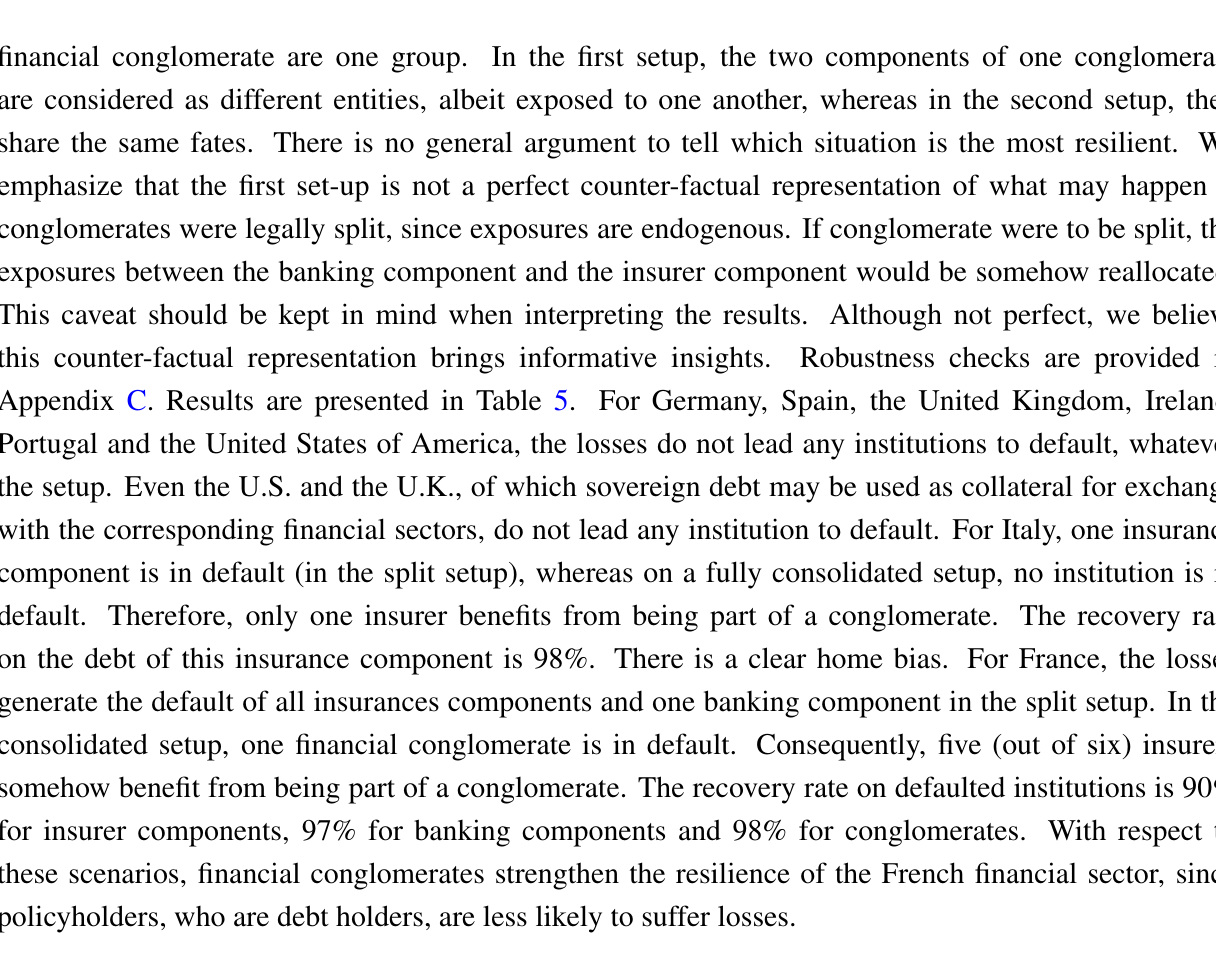
Table 5. Sovereign exposure stress test results. Equity recovery is the average over the non-defaulted institutions of the ratio of equity after shock and equity before shock. Debt recovery is the average over the defaulted institutions of the ratio of debt value after shock and before shock. “.” indicates that the value cannot be